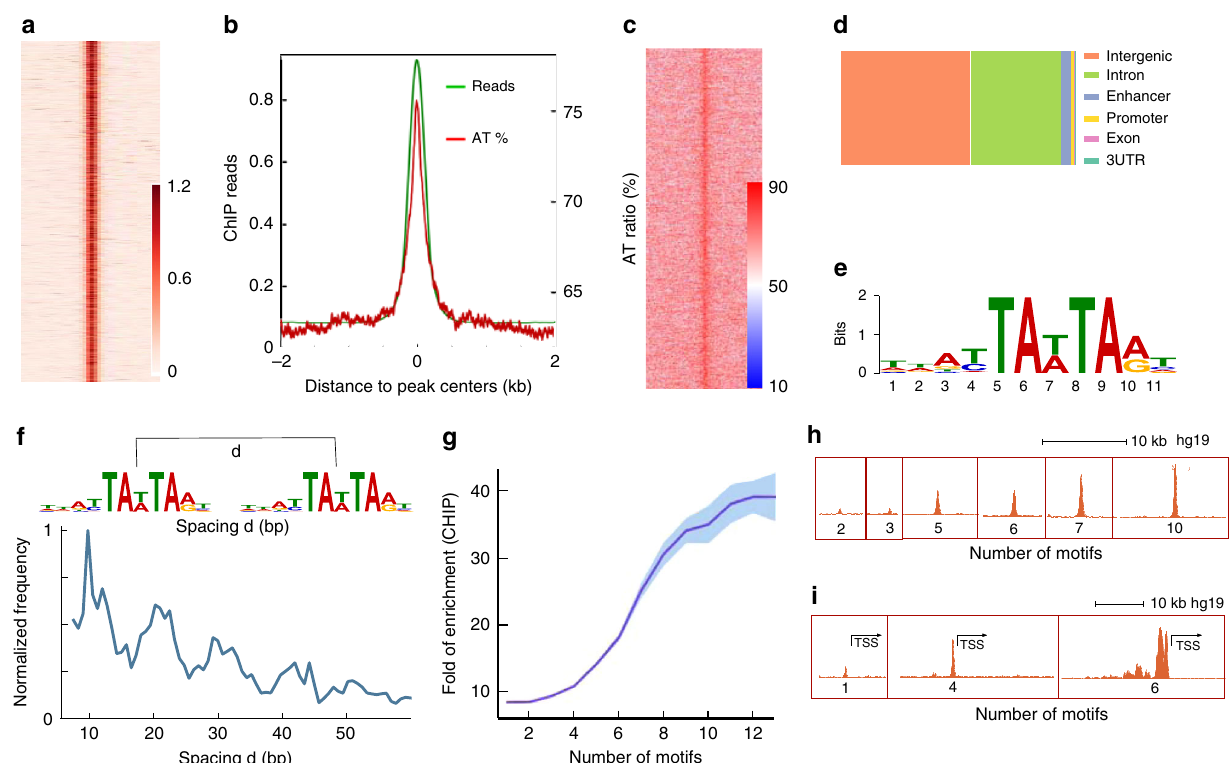
Fig. 2 Genome wide binding of Satb1 reveals clustered distribution and cooperative binding. a Heatmap of ChIP-seq signals (read pileups) along a 4 kb window centered on binding peaks. b Overlay of average ChIP-seq signals (green) and AT percentage (red) along the same 4Kb window as in a . c Heatmap of AT percentage along the 4 kb window as in a . d Relative abundance of Satb1 binding sites in different genomic categories. e Identi fi cation of a Satb1 consensus motif in MCF10A using MEME. f Frequency distribution of the spacing between Satb1 bound motif pairs in a 400bp window, showing ~ 10 bp periodicity. g Satb1 ChIP-seq shows cooperative binding (mean ChIP-seq signal versus number of motifs per binding site reveals a sigmoidal binding curve with a Hill coef fi cient of 5.3. h i . Representative examples of ChIP-seq signal strength classi fi ed by motif density per binding site in gene body ( h ) and proximal to TSS ( i ). All error envelopes represent standard error of mean. Source data are provided as a Source Data fi